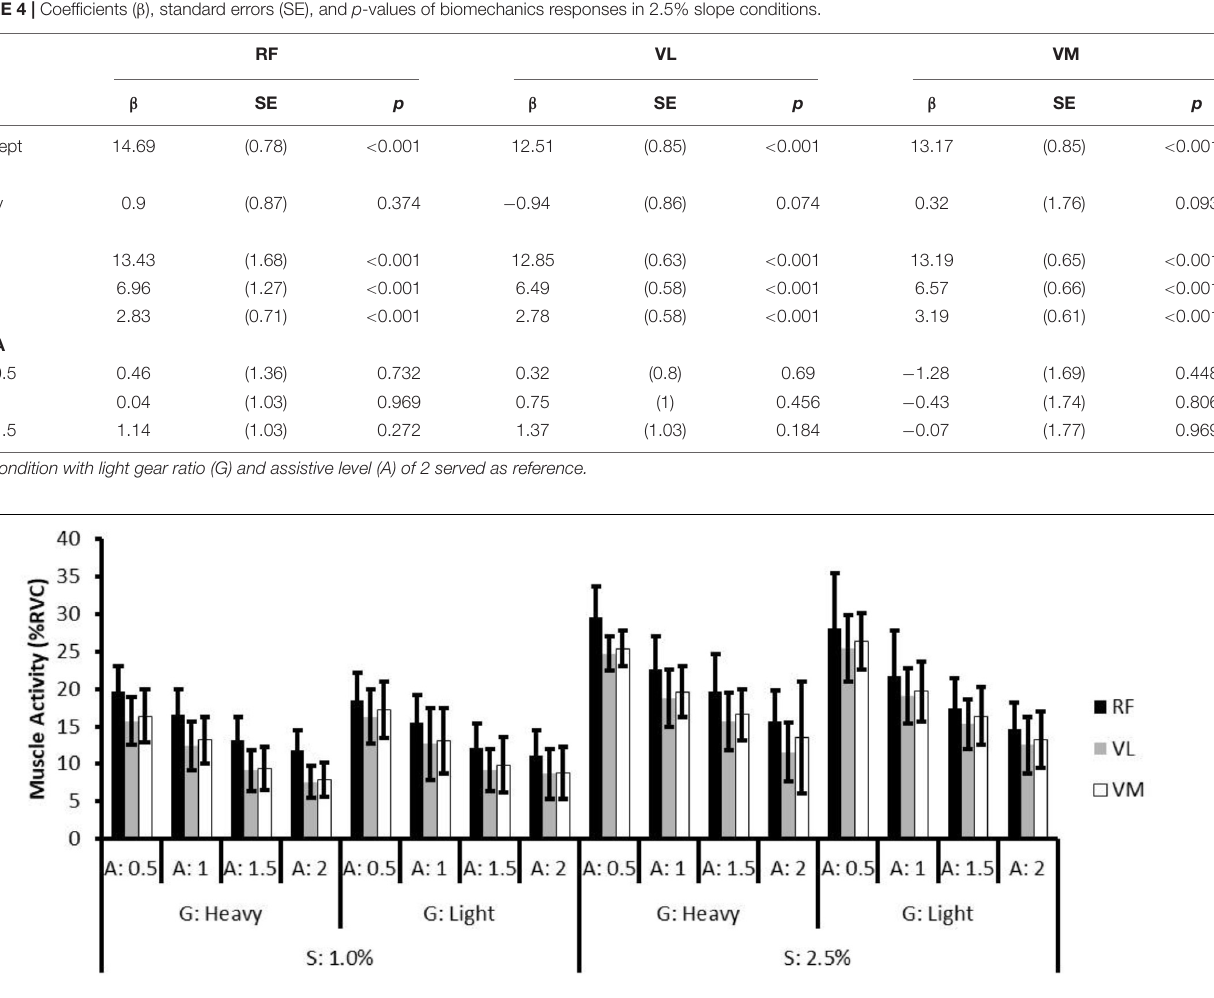
Frontiers in Physiology |